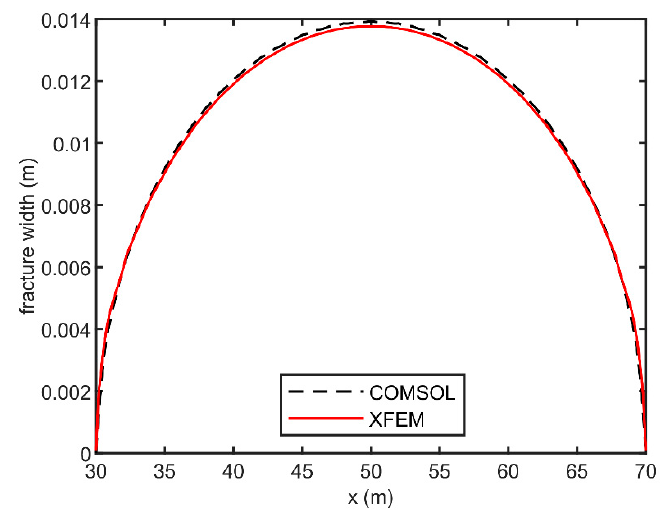
Figure 9. Comparison of the fracture width between UXFEM and COMSOL .